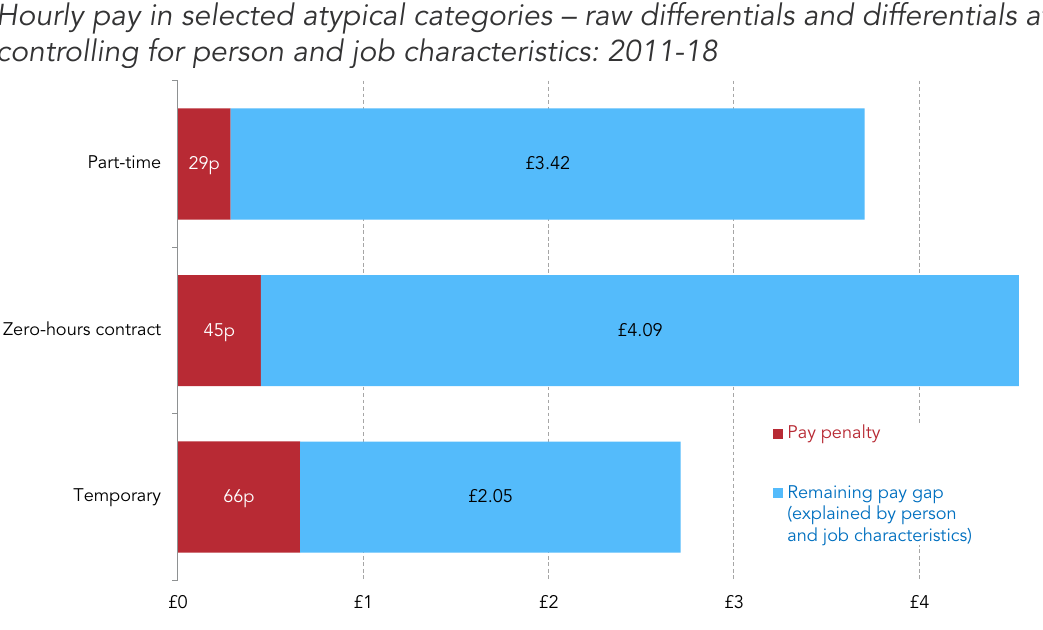
Figure 35: There is a pay penalty attached to atypical employment Hourly pay in selected atypical categories – raw differentials and differentials after controlling for person and job characteristics: